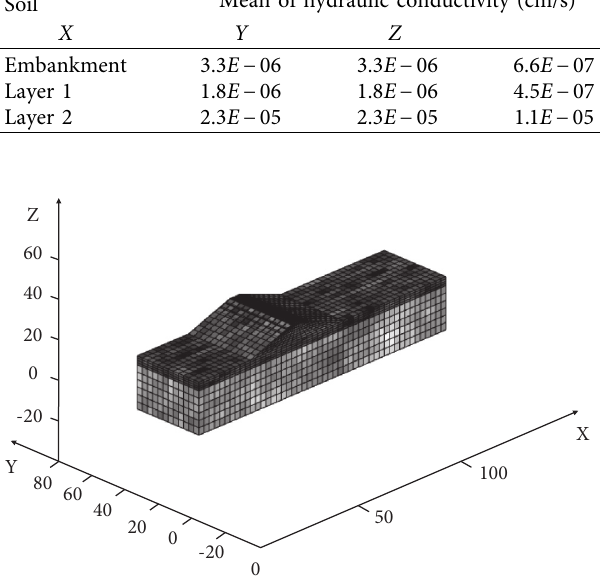
Figure 2: Three-dimensional multilayer random field of hydraulic